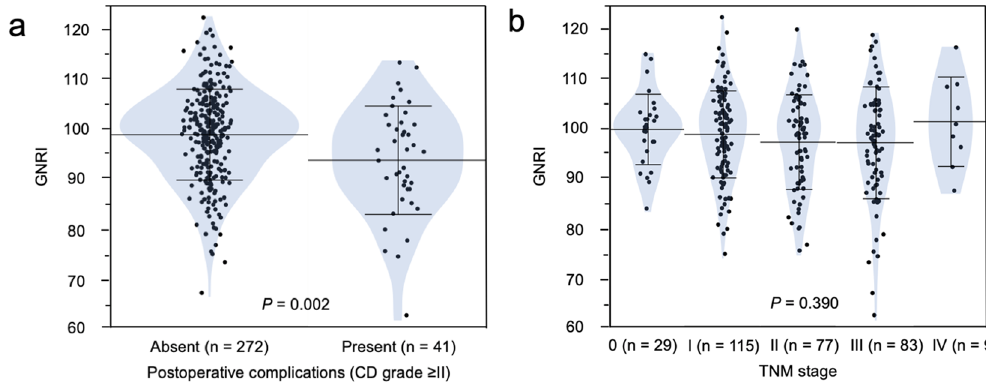
Figure 1. Distribution of GNRI according to ( a ) postoperative complications (Clavien-Dindo grade ≥ II) and ( b ) TNM stages. ( a ) GNRI is significantly lower in patients with postoperative complications than in those without them ( P = 0.002). ( b ) GNRI is not significantly different among TNM stages ( P =